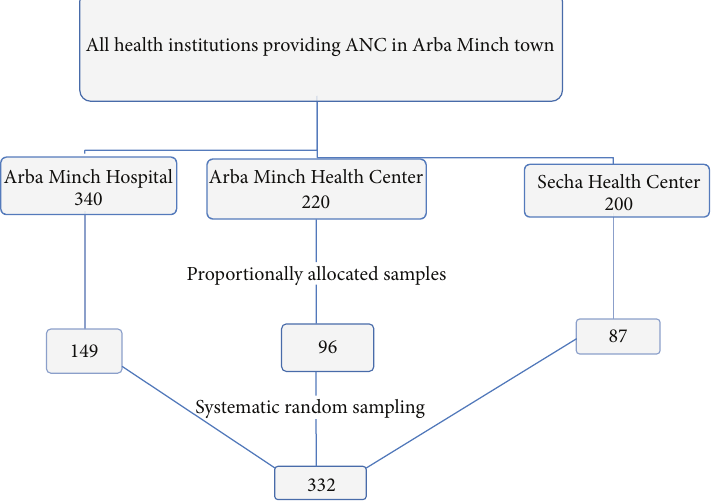
Figure 1: Schematic presentation of sampling procedure in public health institutions of Arba Minch town, 2014 ( 𝑛 = 332 ).